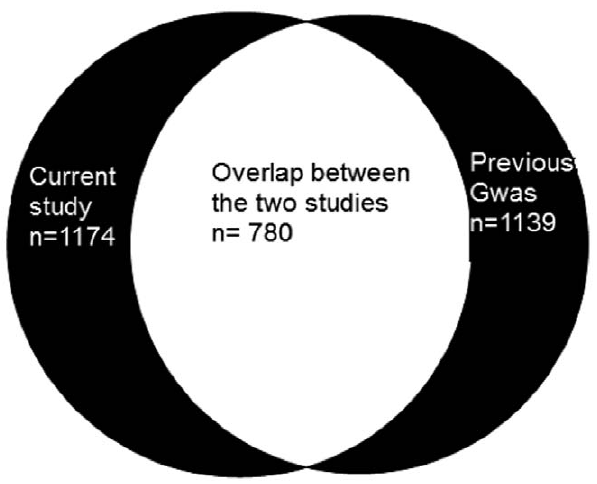
Figure 1. The overlap of study subjects between the current study (n=1974) and the previous genome-wide association study (GWAS, n=1139) [ 29 ] . doi:10.1371/journal.pone.0041618.g001 PLoS ONE |